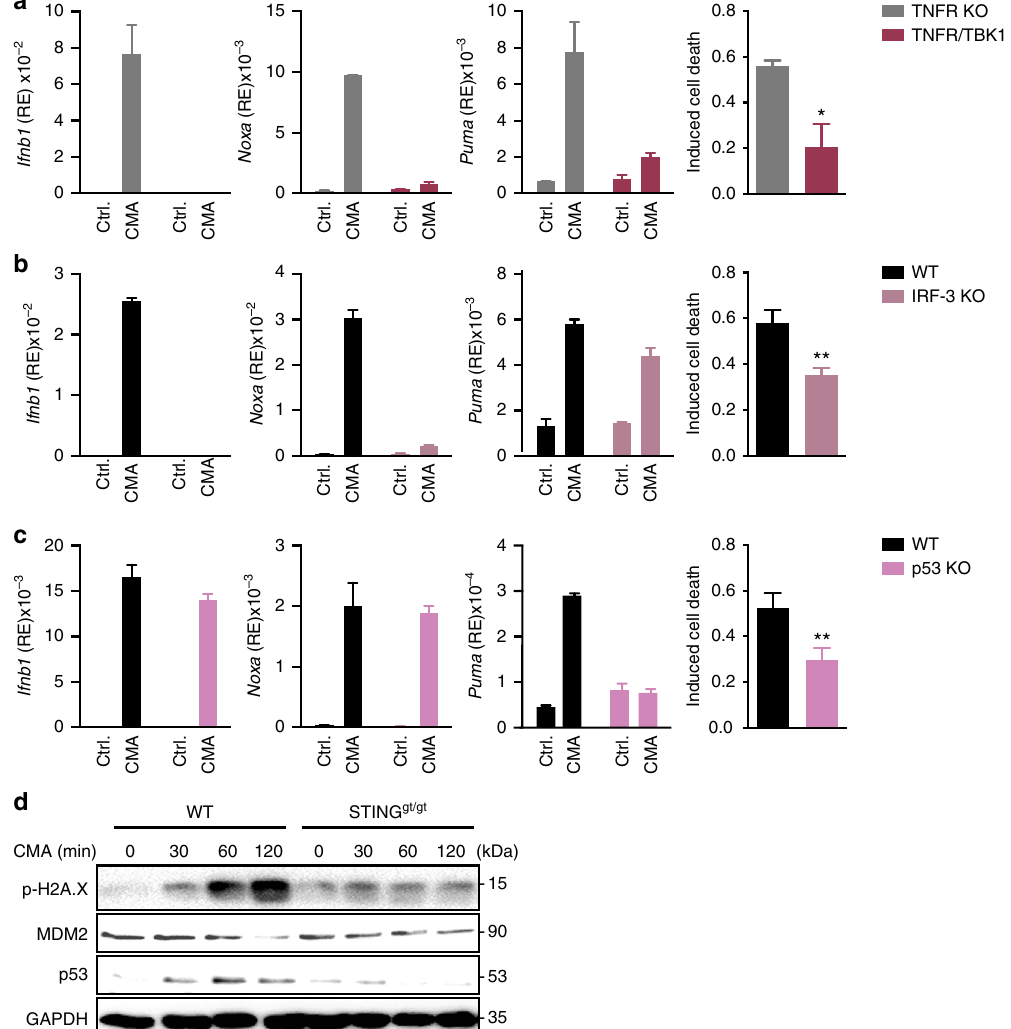
Fig. 4 Cooperation of IRF-3 and p53 for the STING-mediated proapoptotic transcriptional programme. a – c CD4 + T cells of the indicated genotypes were treated with DMSO or 10-carboxymethyl-9-acridanone (CMA). After 16 h the percentage of apoptotic cells was assessed by Annexin V and 7-AAD staining (right) or upregulation of depicted genes was determined by RT-qPCR (left). d CD4 + T cells from wild-type (WT) or STING gt/gt mice were stimulated with CMA for the indicated times and p53, MDM2 and phosphorylation of Histone H2A.X were assessed by immunoblot. Data are representative of n = 2 d independent experiments or mean and s.d. of technical replicates of one representative experiment out of n = 3 independent experiments are shown a – c . * P < 0.05 and ** P < 0.01 (Student ’ s t -test). Unprocessed original blots are shown in Supplementary Fig.